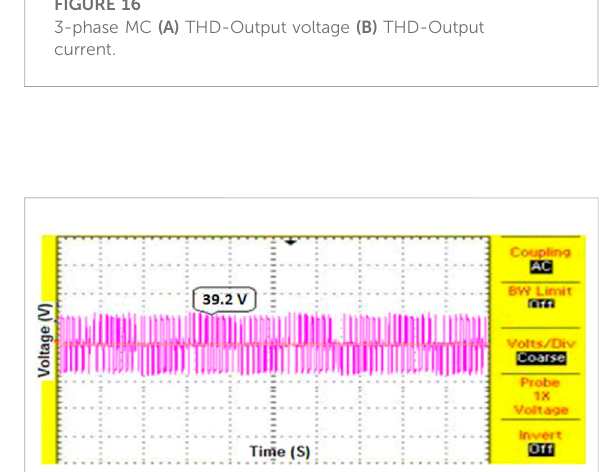
FIGURE 17 CMV reduction for MC using 3D-SVPWM.